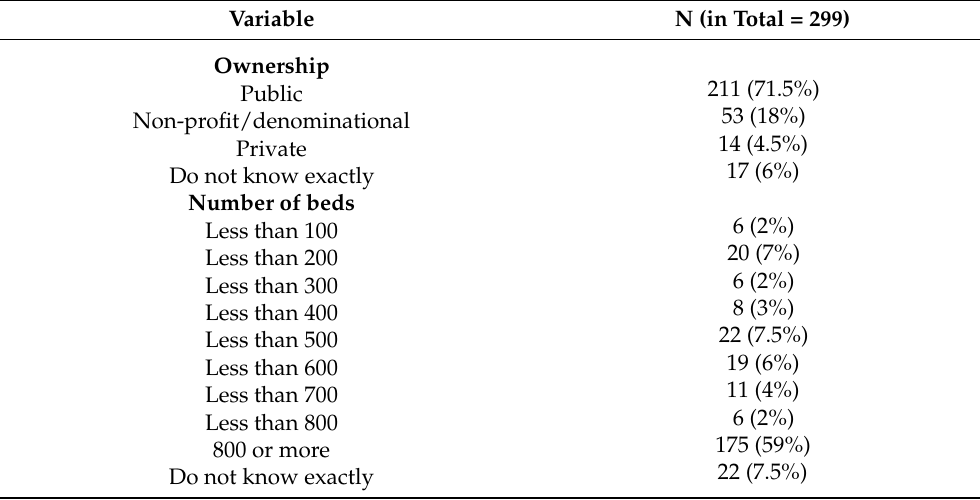
Table 2. Baseline characteristics of the respondents’